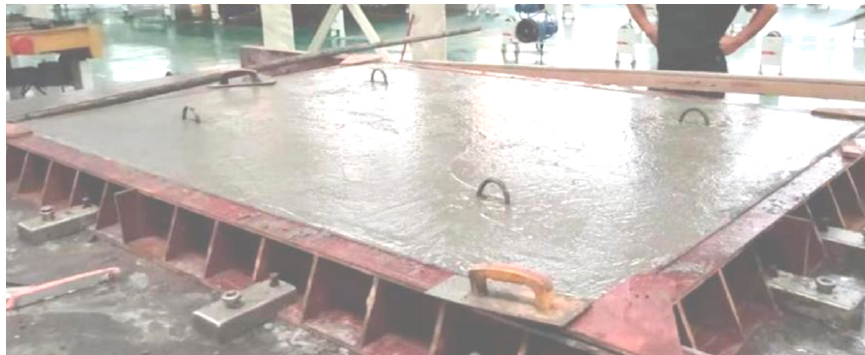
Figure 2. Pouring diagram of sandwich laminated floor slab.